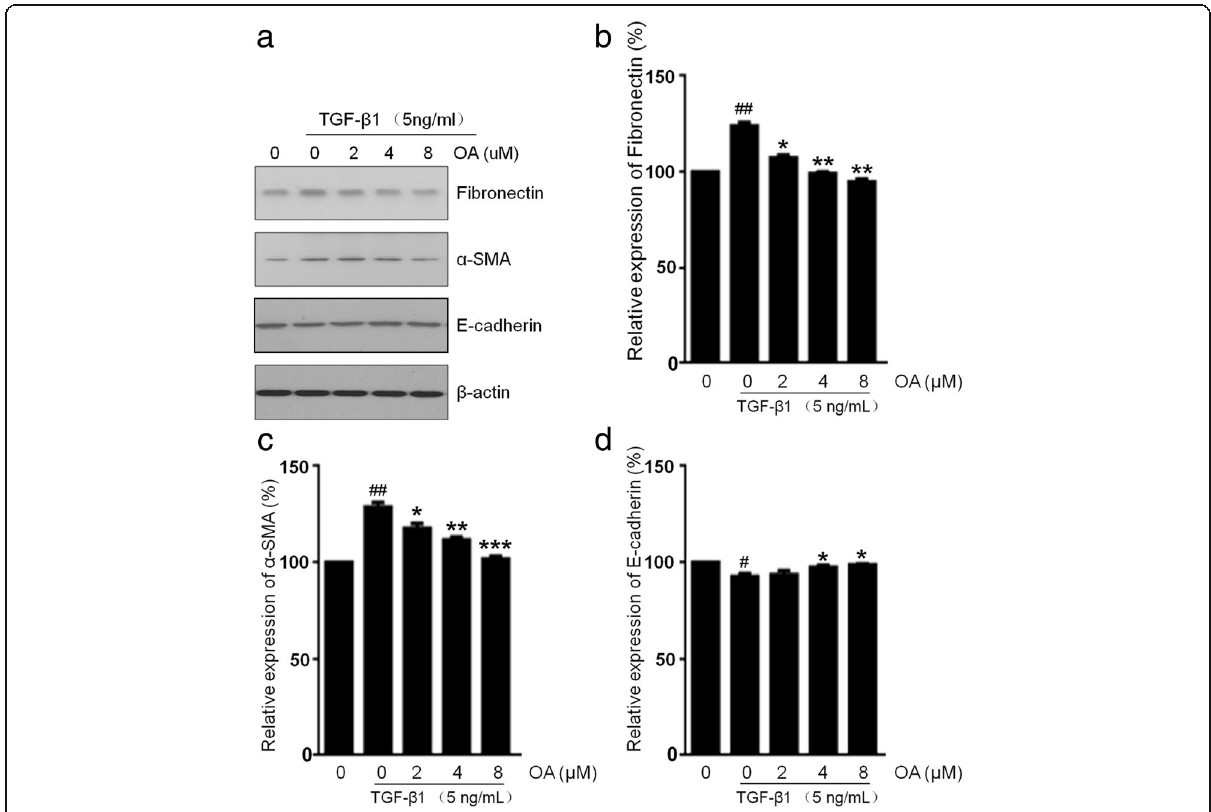
Fig. 3 Effects of OA on TGF- β 1-induced EMT in NRK-52E cells. The cells were incubated with 5 ng/mL of TGF- β 1 for 48 h with different concentrations of OA (0, 2, 4, 8 μ M). a The expression of Fibronectin, α -SMA and E-cadherin was determined by Western blotting. b , c , d The expression level was quantitatively analyzed with Image J software. The data showing mean ± SD. # P < 0.05, ## P < 0.01, and ### P < 0.005 vs. 0 ng/mL TGF- β 1. * P < 0.05, ** P < 0.01, and *** P < 0.005 vs. 0 μ M OA in the presence of 5 ng/mL TGF- β